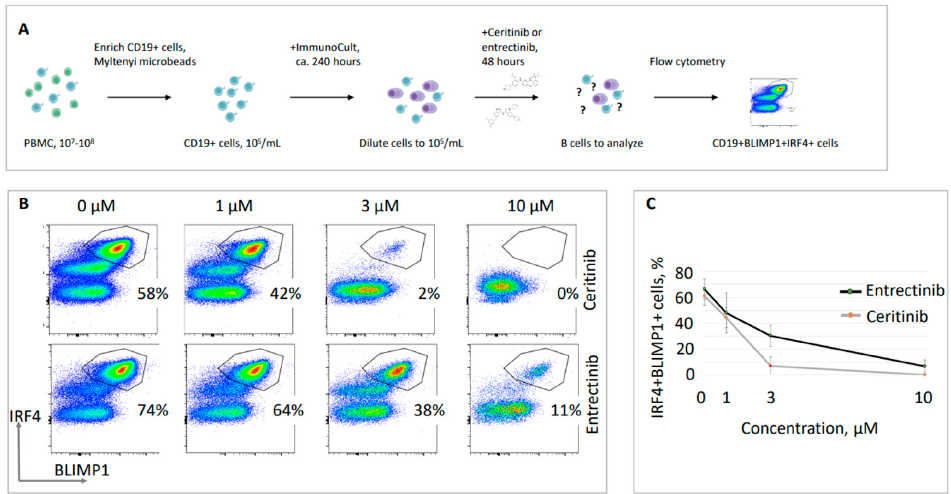
Figure 3. Reduced proportions of IRF4+BLIMP1+ cells in the presence of tyrosine kinase inhibitors ceritinib and entrectinib. ( A ) Schematic overview of the experiment. ( B ) Representative live CD19- positive B cell populations labeled with BLIMP1 and IRF4 to select mature antibody-secreting B cells (plasma cells). Exposure to increasing concentrations of ceritinib and entrectinib (1 µM, 3 µM, and 10 µM) resulted in reduced populations of BLIMP1/IRF4 double-positive mature B lymphocytes. ( C ) Summary of three experiments similar to one shown in ( B ) with standard deviation. Samples from different donors were used to generate every data point.